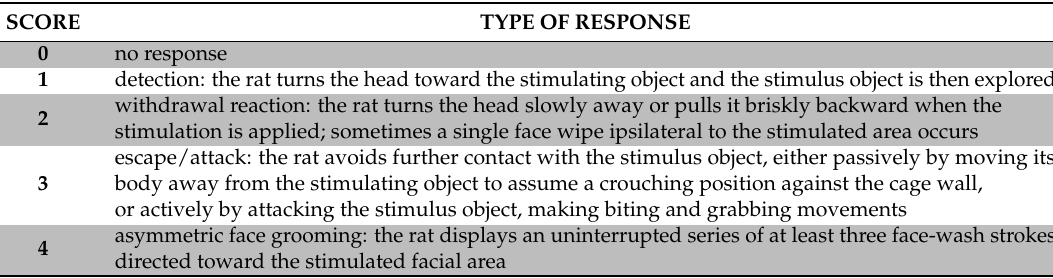
Table 1. Response categories with the corresponding score